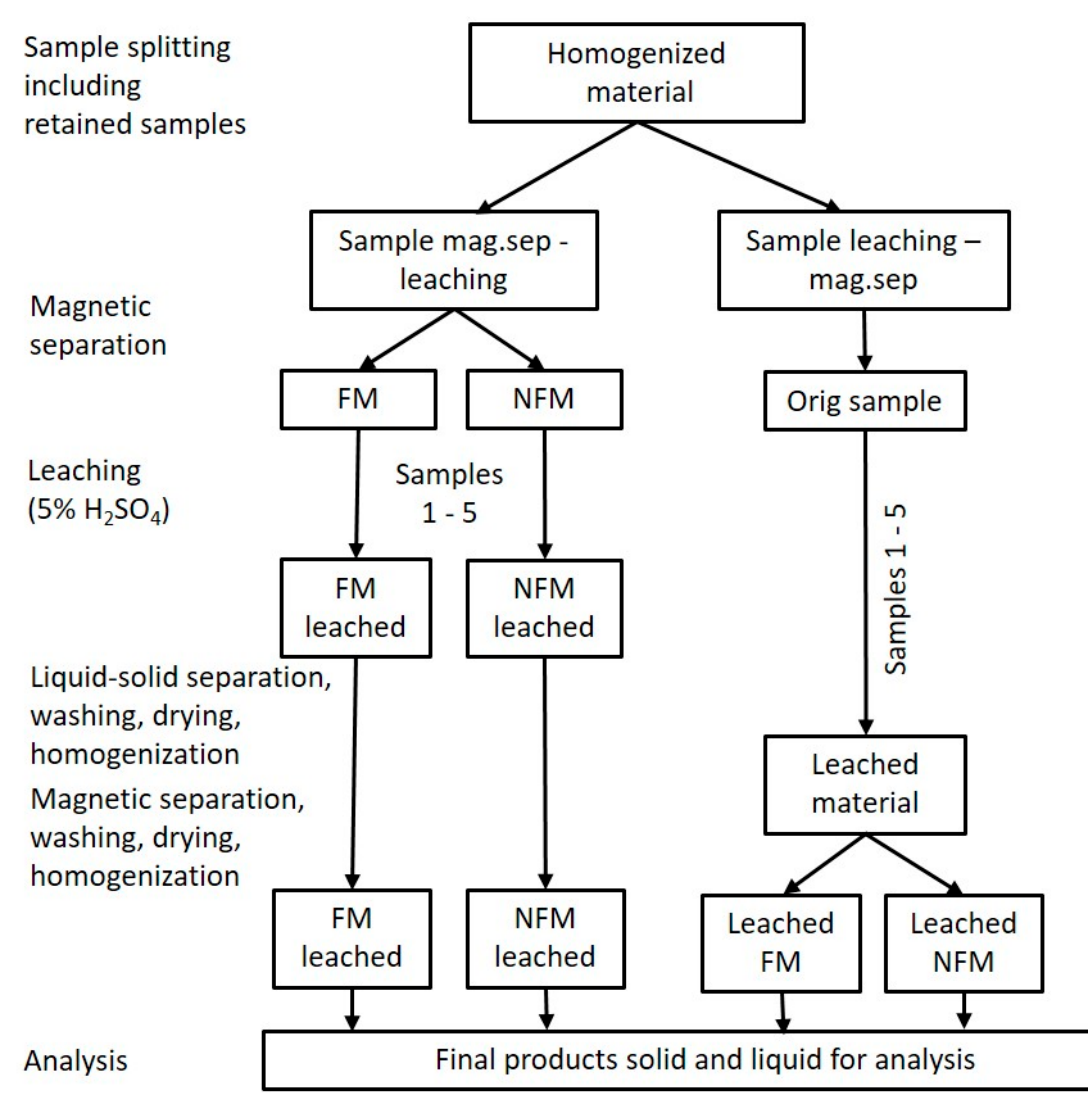
Figure 8. Processing scheme of magnetic separation in combination with leaching. Each test was carried out with around 8.5 kg sample material. FM: ferromagnetic, NFM: non ferromagnetic.